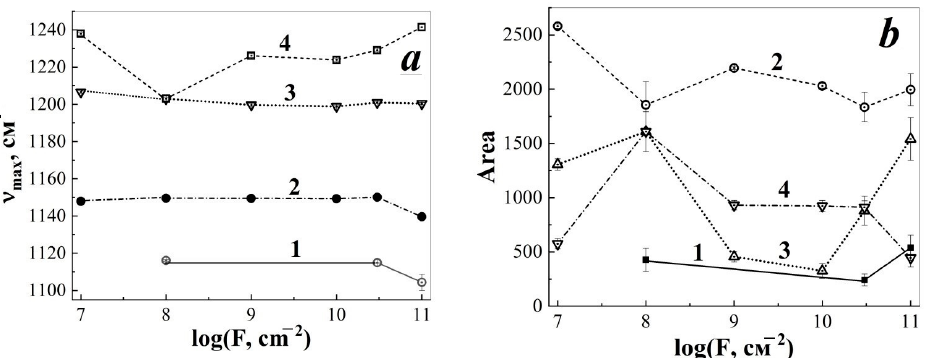
Figure 3. Change in the position of maxima ( a ) and peak areas ( b ) of oscillatory modes 1116 (1), 1147 (2), 1206 (3), 1238 (4) cm − 1 in the infrared spectra of the disturbed total internal reflection of thermoradiationally modified polytetrafluoroethylene depending on the fluence of xenon ions with an energy of ~1 MeV/nucleon.